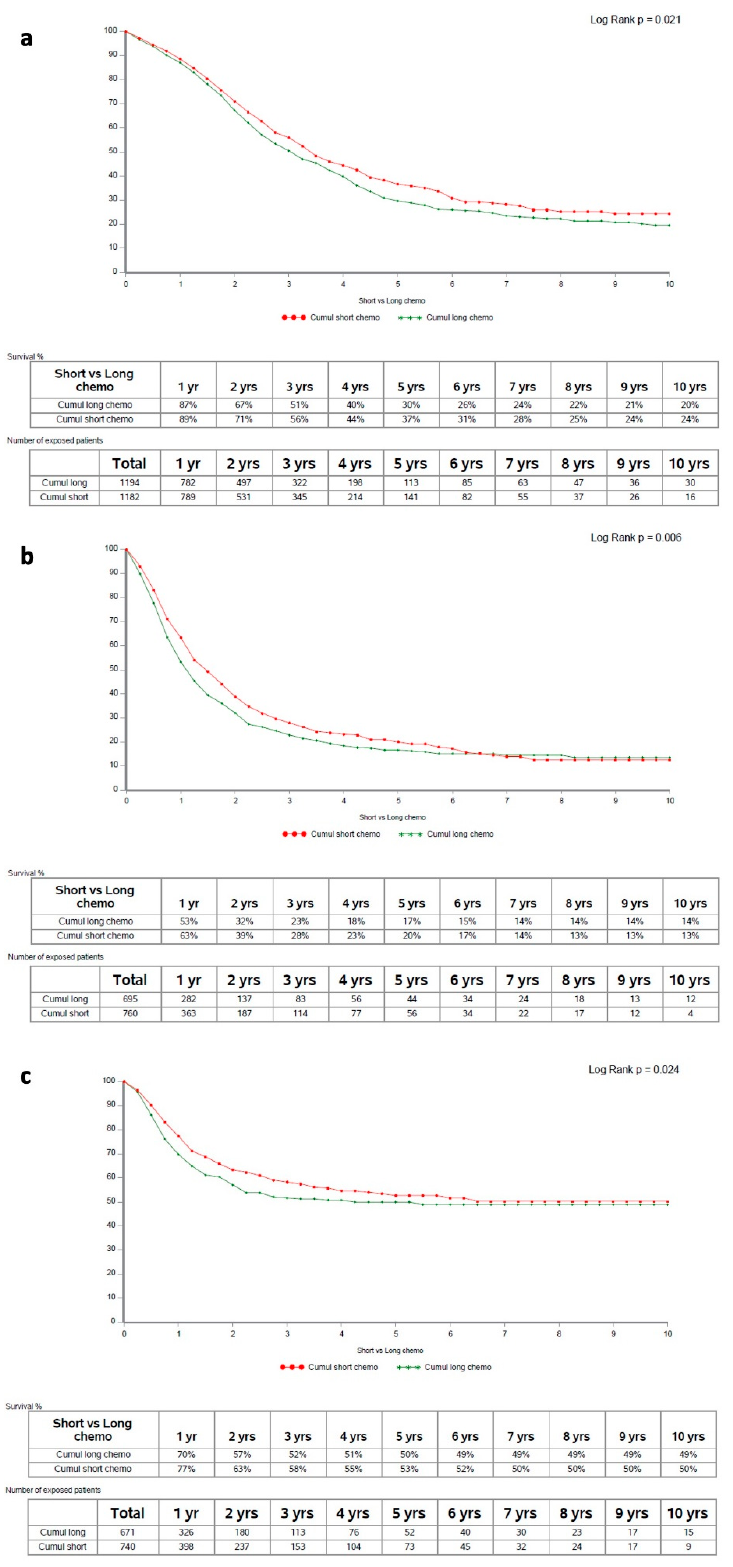
Figure 2. Survival curves according to PO-SACT duration: panel ( a ) OS; panel ( b ) DFS; panel ( c ) HS- RFS. PO-SACT: pre-operative systemic anticancer therapy; OS: overall survival; DFS: disease-free survival; HS-RFS: hepatic-specific relapse-free